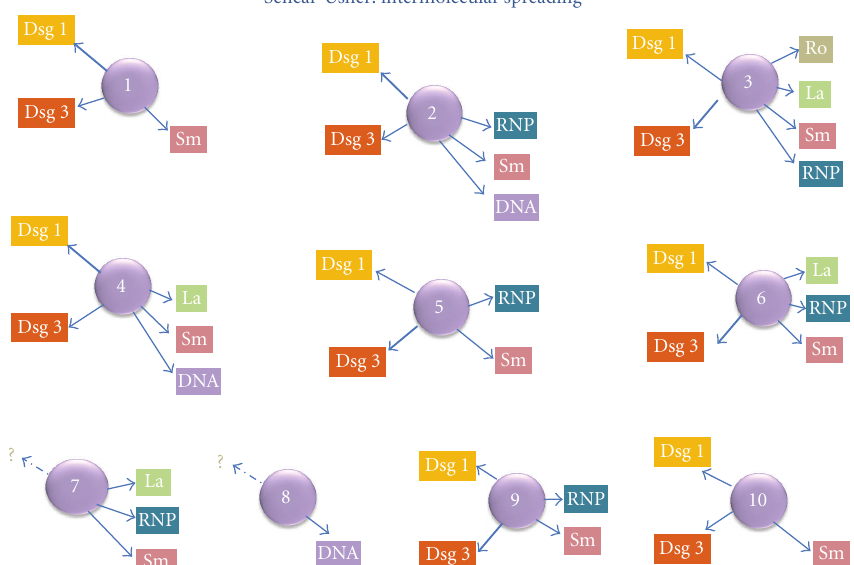
Figure 4: Multiple molecular reactivity of pemphigus erythematosus patient sera to desmosome and ribonucleoprotein components. This result may indicate intermolecular antigen spreading.